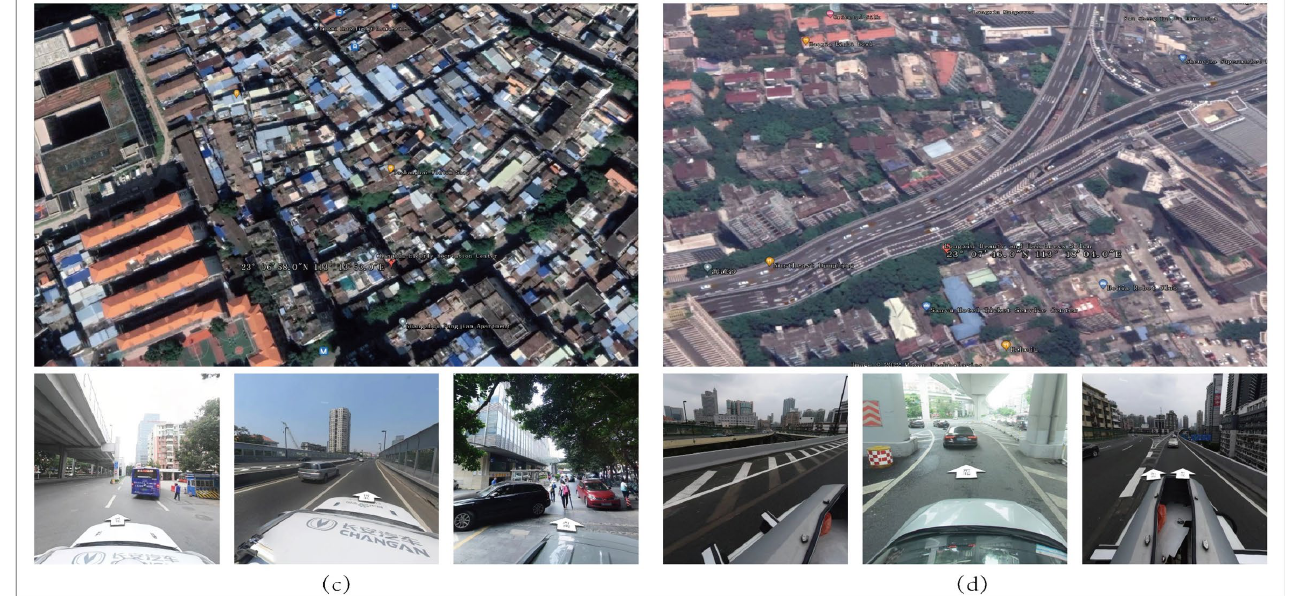
Figure 1. Overview of the study area and atmospheric monitoring stations. ( a ) Location of three stations; ( b ) Luhu station (LH); ( c ) Huangsha station (HS); ( d ) Yangji station (YJ). Meteorological data were obtained from Guangzhou Weather website (http://www.tqyb.com.cn/gz/weatherLive/autoStation/, accessed on 1 July 2021),